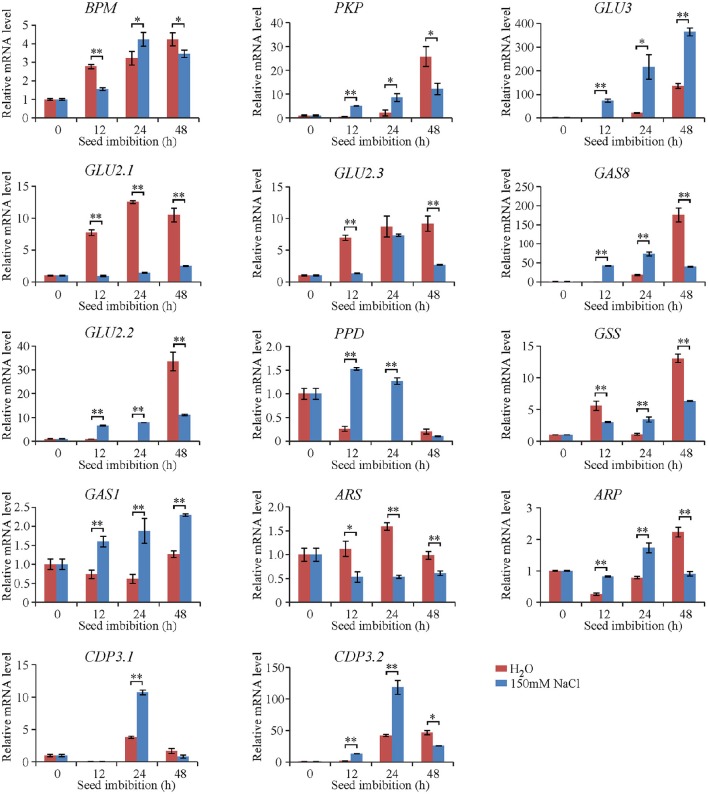
Expression pattern of genes during seed imbibition under distilled water and salt conditions based on quantitative RT–PCR analysis. The mRNA level of genes was normalized to that of 18S ribosomal RNA gene control. Each column represents means ± standard deviation. * and ** indicated the significant difference at 5 and 1% levels between water and salt conditions, respectively.